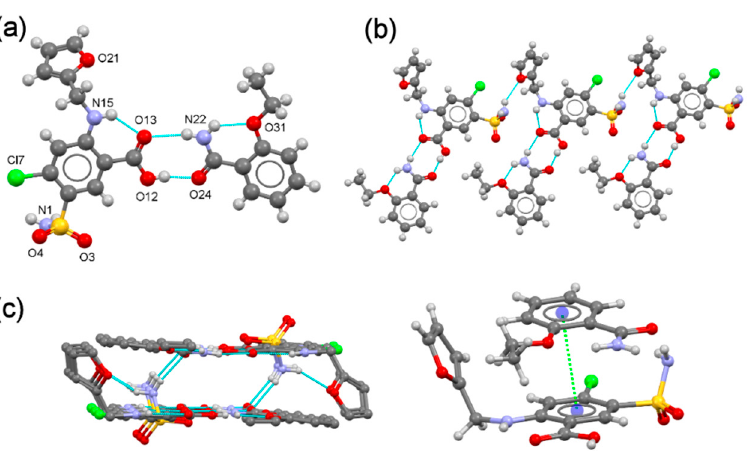
Figure 2. ( a ) Asymmetric unit of the FUR–ETZ cocrystal. ( b ) acid · · · amide and sulfonamide · · · furan synthons give a ribbon along the b -axis by H-bonding interactions (Table S1). ( c ) Left. Detail of the column structure in FUR–ETZ. Carbon bound H atoms omitted for clarity Right. π − π stacking interaction in the FUR–ETZ